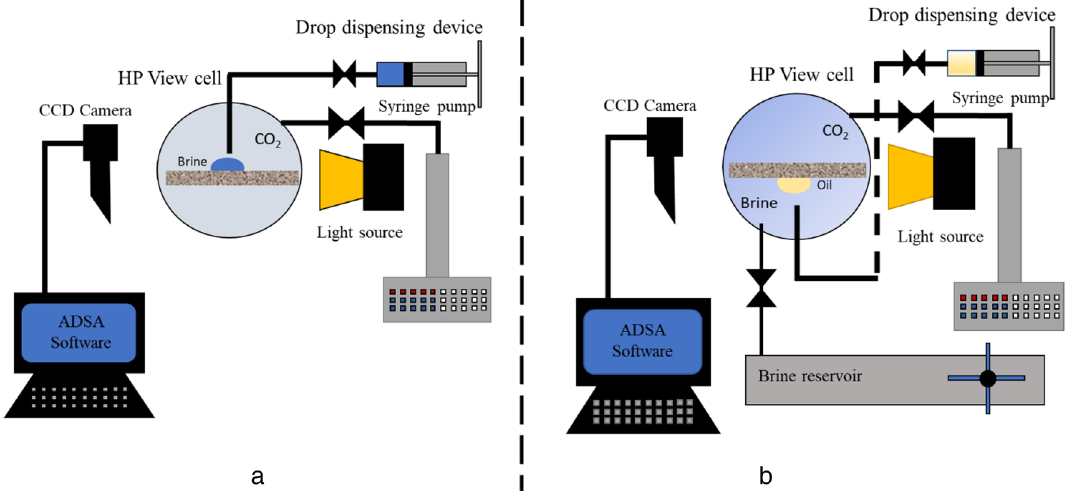
Fig. 3 Schematic diagram of experimental setup: a Sessile drop configuration and b Captive bubble